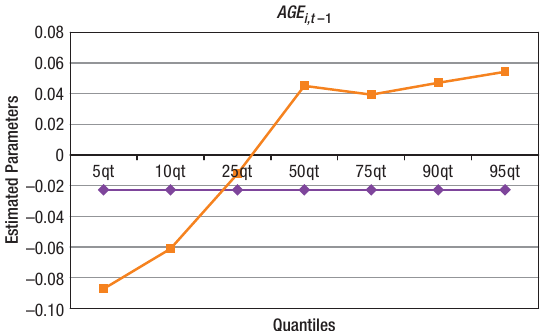
Fig. 4. Estimated parameters of relationship between I Notes: 1. The linear relationship represents OLS regression. 2. The non-linear relationship represents quantile